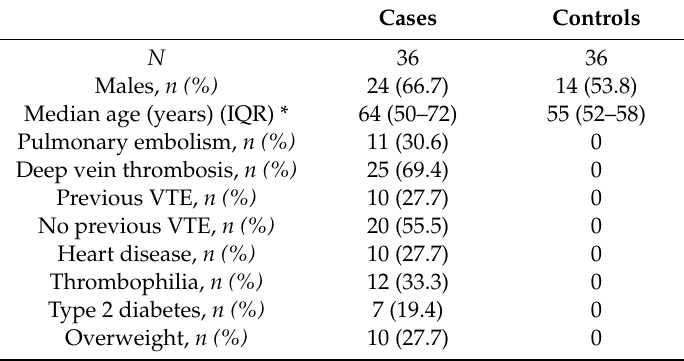
Table 1. Table shows the age and clinical characteristic of the venous thromboembolism (VTE) patients and of